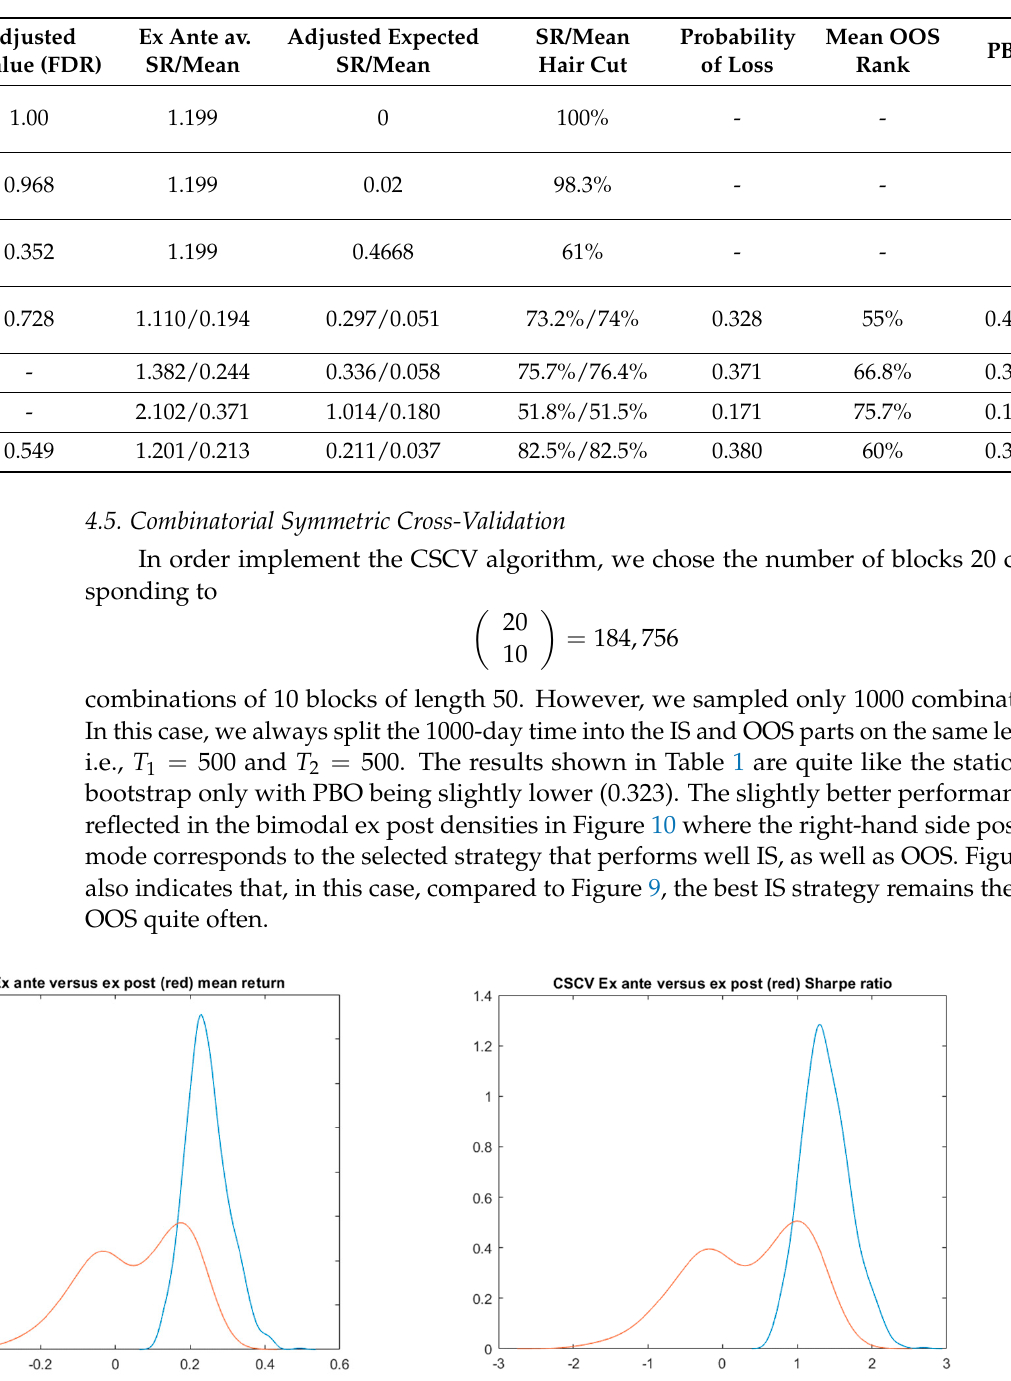
Table 1. Summary of the backtest overfitting tests’ results.